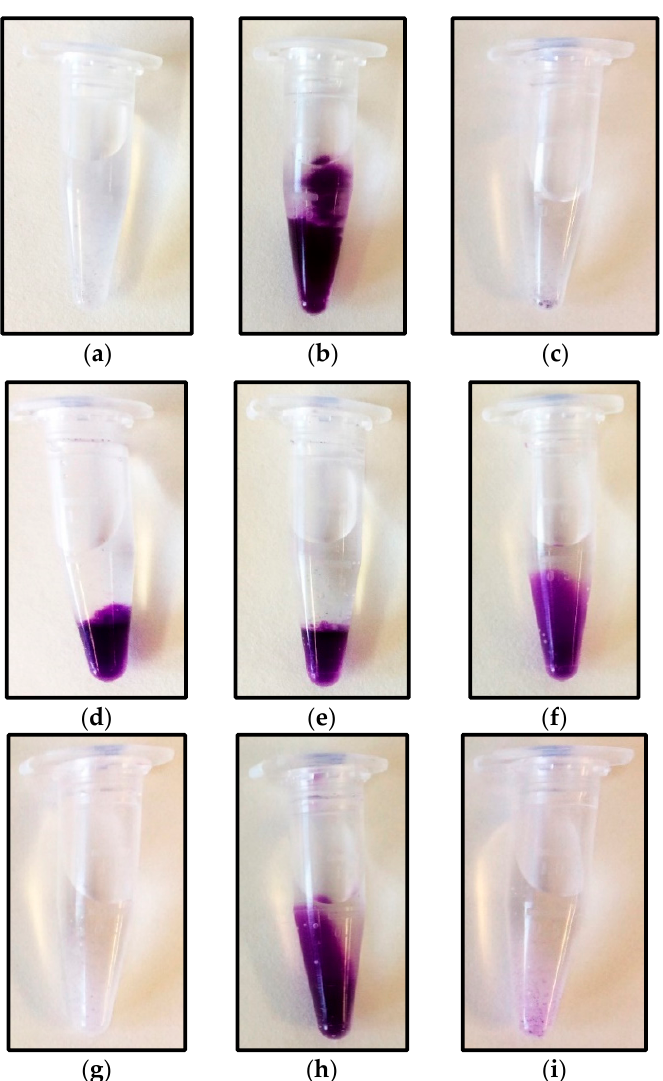
Figure 2. Detection of the free aldehydes by Schiff’s reagent assay. A purple color indicates the presence of free aldehydes and a white color indicates the absence of aldehydes. All of the pictures were taken after 30 min of incubation with Schiff’s reagent at 25 °C. All the blocking incubations were done for 18 h at 25 °C using Agarose GA 10BCL in all cases: ( a ) Non-activated agarose beads; ( b ) Non-reduced GA support; ( c ) GA support reduced with NaBH 4 ; ( d ) GA support incubated with buffer 0.8 M Tris pH 9 plus 20% DMSO in the absence of 2-PB; ( e ) GA support incubated with buffer 0.8 M Tris pH 9, plus 20% DMSO in the presence of 40 mM 2-PB; ( f ) GA support incubated with buffer 0.8 M glycine pH 9, plus 20% DMSO in the absence of 40 mM 2-PB; ( g ) GA support incubated with buffer 0.8 M glycine pH 9, plus 20% DMSO in the presence of 40 mM 2-PB; ( h ) GA support incubated with buffer 0.8 M ethanolamine pH 9, plus 20% DMSO in the absence of 40 mM 2-PB; ( i ) GA support incubated with buffer 0.8 M ethanolamine pH 9, plus 20% DMSO in the presence of 40 mM 2-PB.